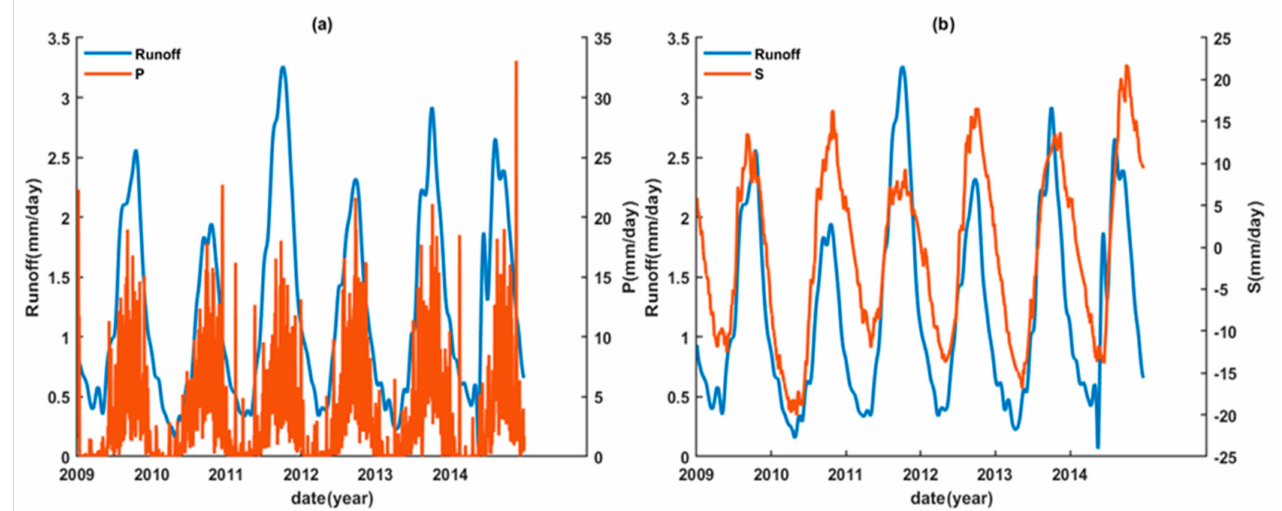
Figure 6. Time series of ( a ) TRMM daily precipitation (i.e., P) (66 lagged days) and ( b ) GRACE daily land water storage (i.e., S) (16 lagged days) spatially averaged over Yunnan Province at the upstream Mekong Basin against the in situ runoff during